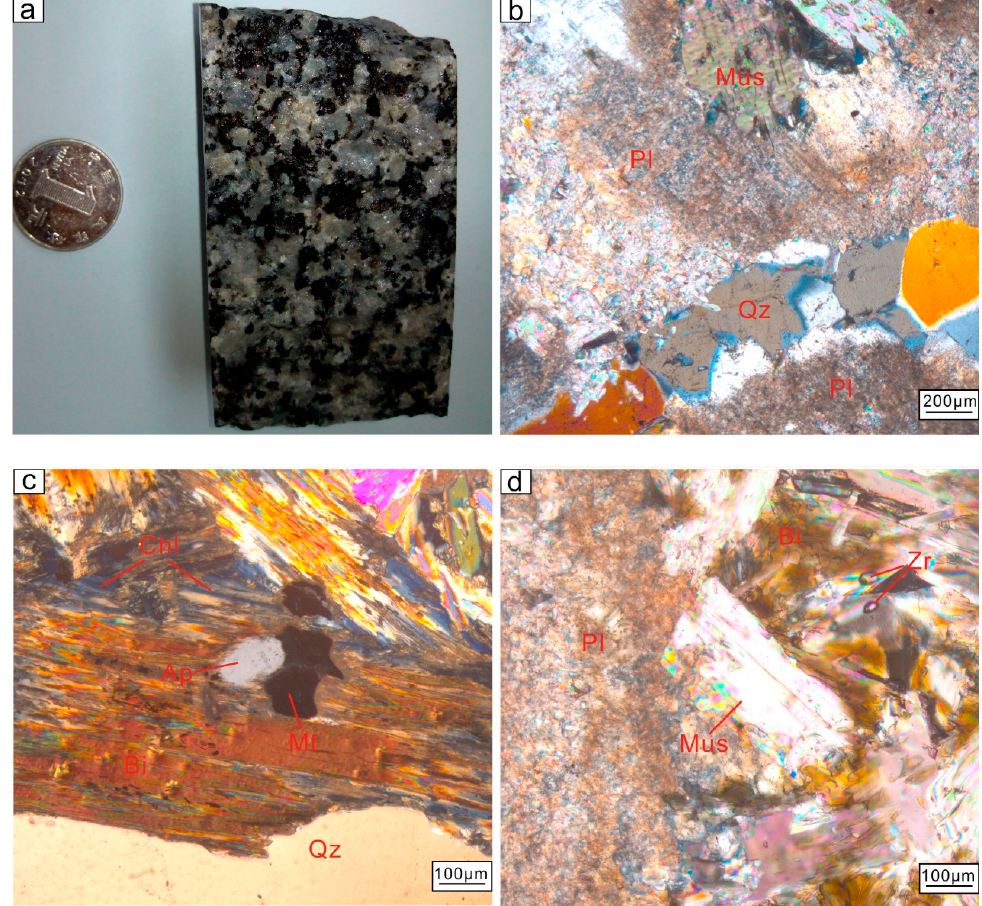
Figure 3. Hand specimen photo and photomicrographs of the Shimensi granodiorite. ( a ) Hand specimen photo of sample SMS-14; ( b ) Photomicrograph of sample SMS-12, showing a quartz vein crosscutting the moderately sericite-altered granodiorite; ( c ) Photomicrograph of sample SMS-15, showing that biotite is partly muscovite- and chlorite-altered with accessory apatite; ( d ) Photomicrograph of sample SMS-23, which comprises plagioclase, quartz, biotite and muscovite with accessory zircon. Bi = biotite; Mus = muscovite; Pl = plagioclase; Qz = quartz; Chl = chlorite; Ap = apatite; Mt = magnetite; Zr = zircon.